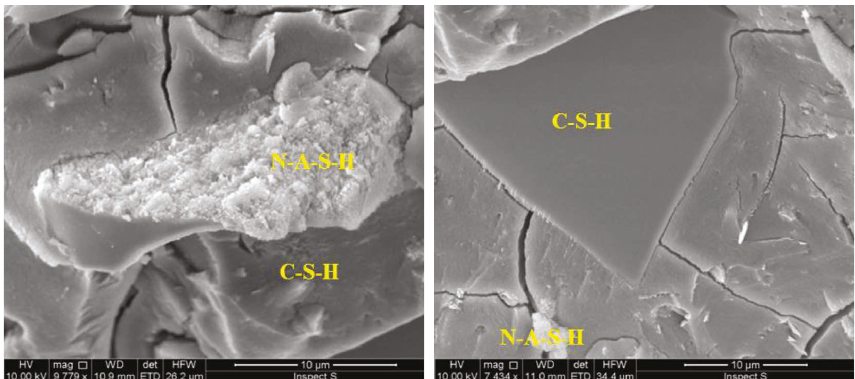
Figure 13: The SEM images for 90GMS geopolymer paste at 35 curing